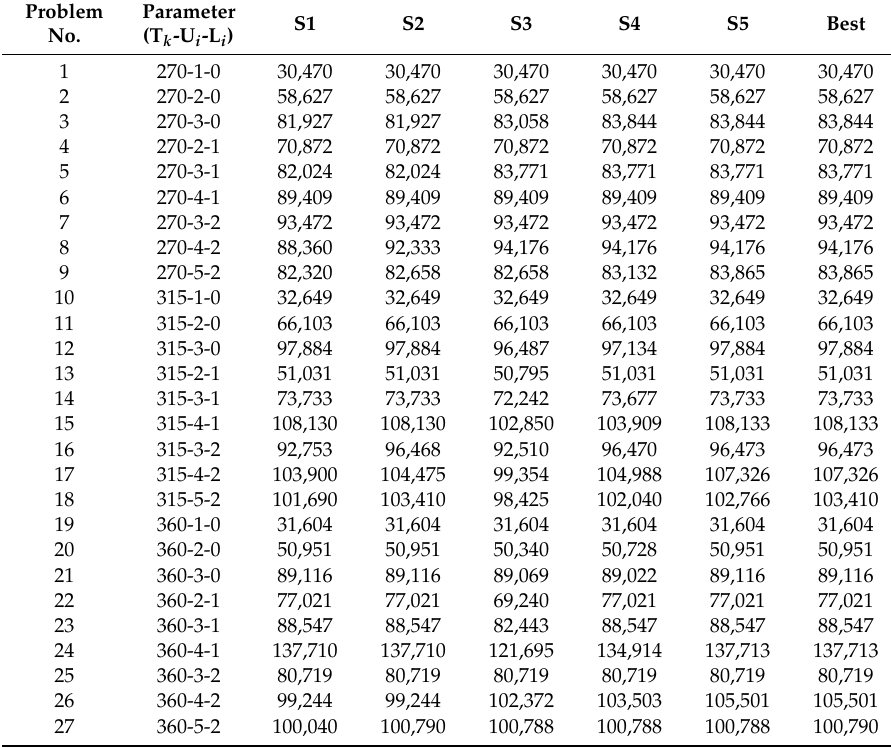
Table 3. Average profits of the five solution methods for the small problem (M, N) = (2, 6). Problem No.